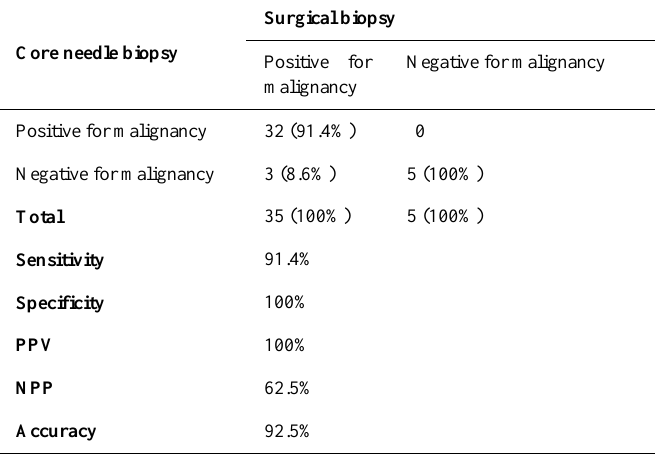
diagnosis and immunophenotype for a locally advanced